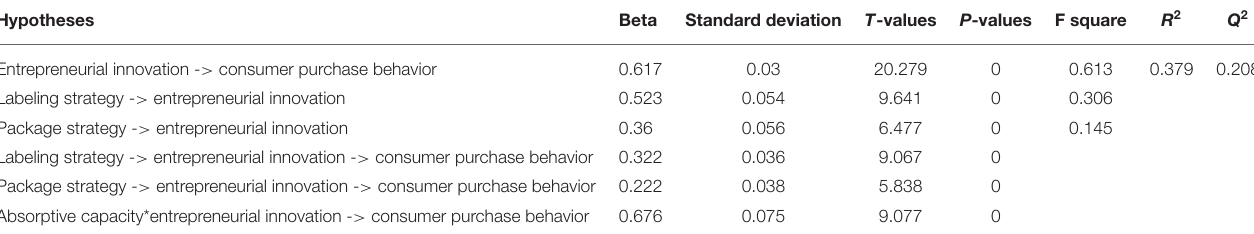
TABLE 4 | Hypothesis